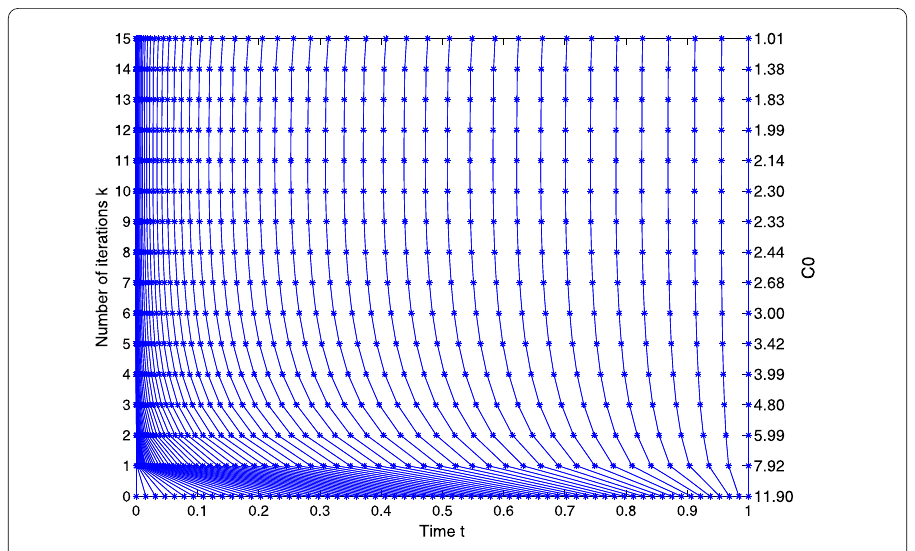
Figure 1 Evolution of the time mesh for Example 5.1 with α = 0.2